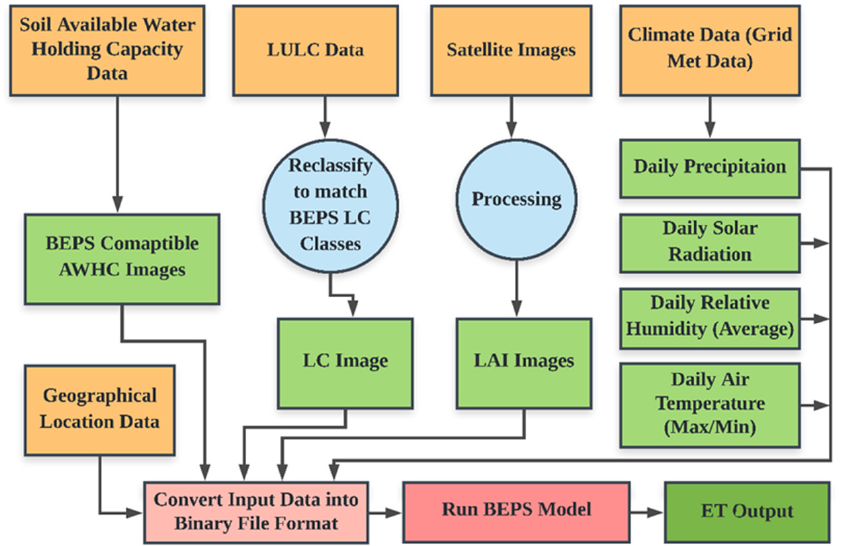
Figure 4. Workflow of the input data preparation and BEPS model simulation.